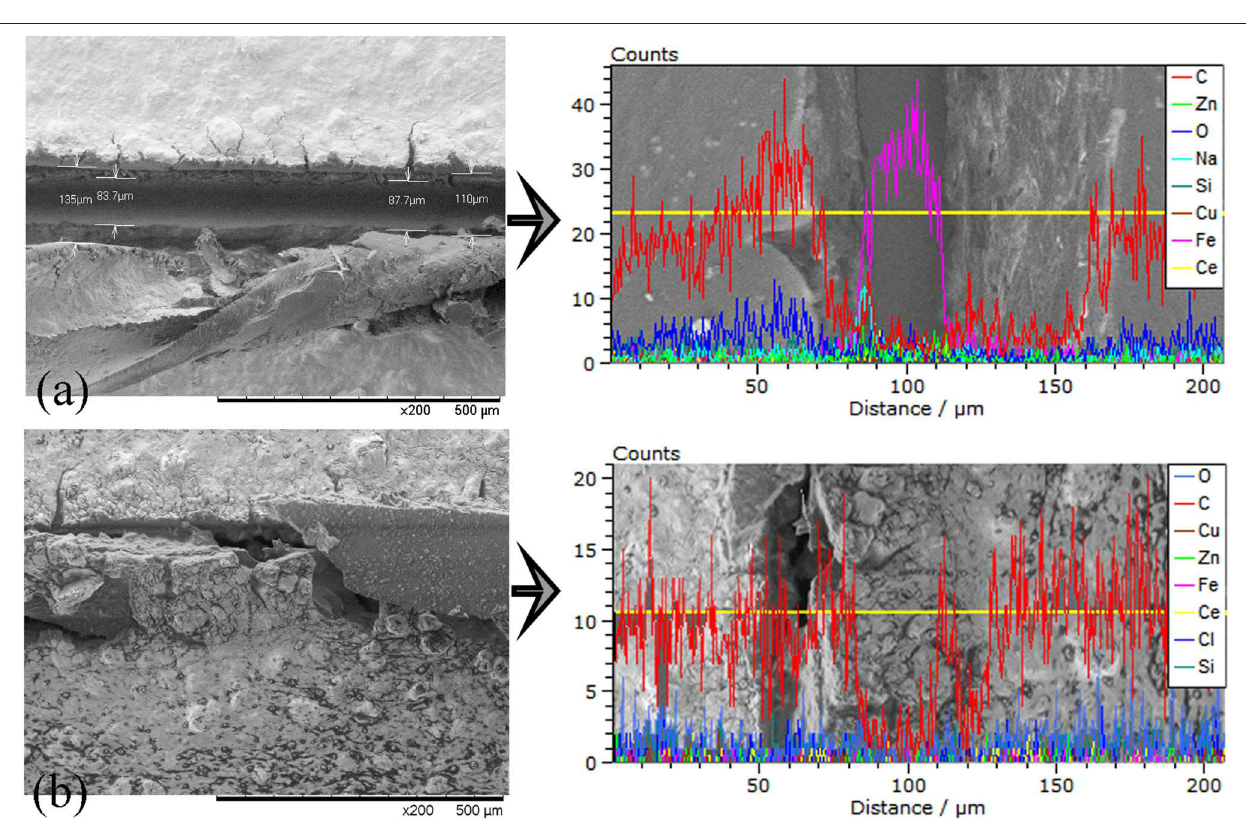
( Table 3 ). The results for Epoxy-CSmc further confirm the observation through SEM that there is also a material